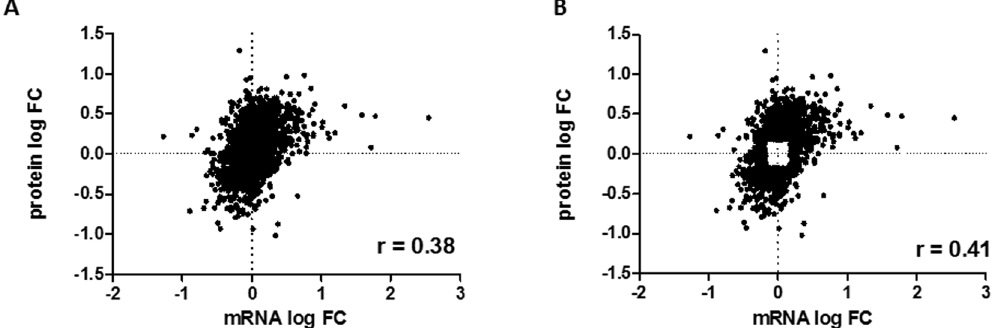
Figure 1. Correlation between changes in RNA and protein. Scatterplots with associated correlation coefficients(r) for ( A ) genes detected in both our mRNA and protein expression datasets (n = 4436); ( B ) genes displaying a significant (p = 3.376 × 10–79) change in expression between the OV and OM samples (n =